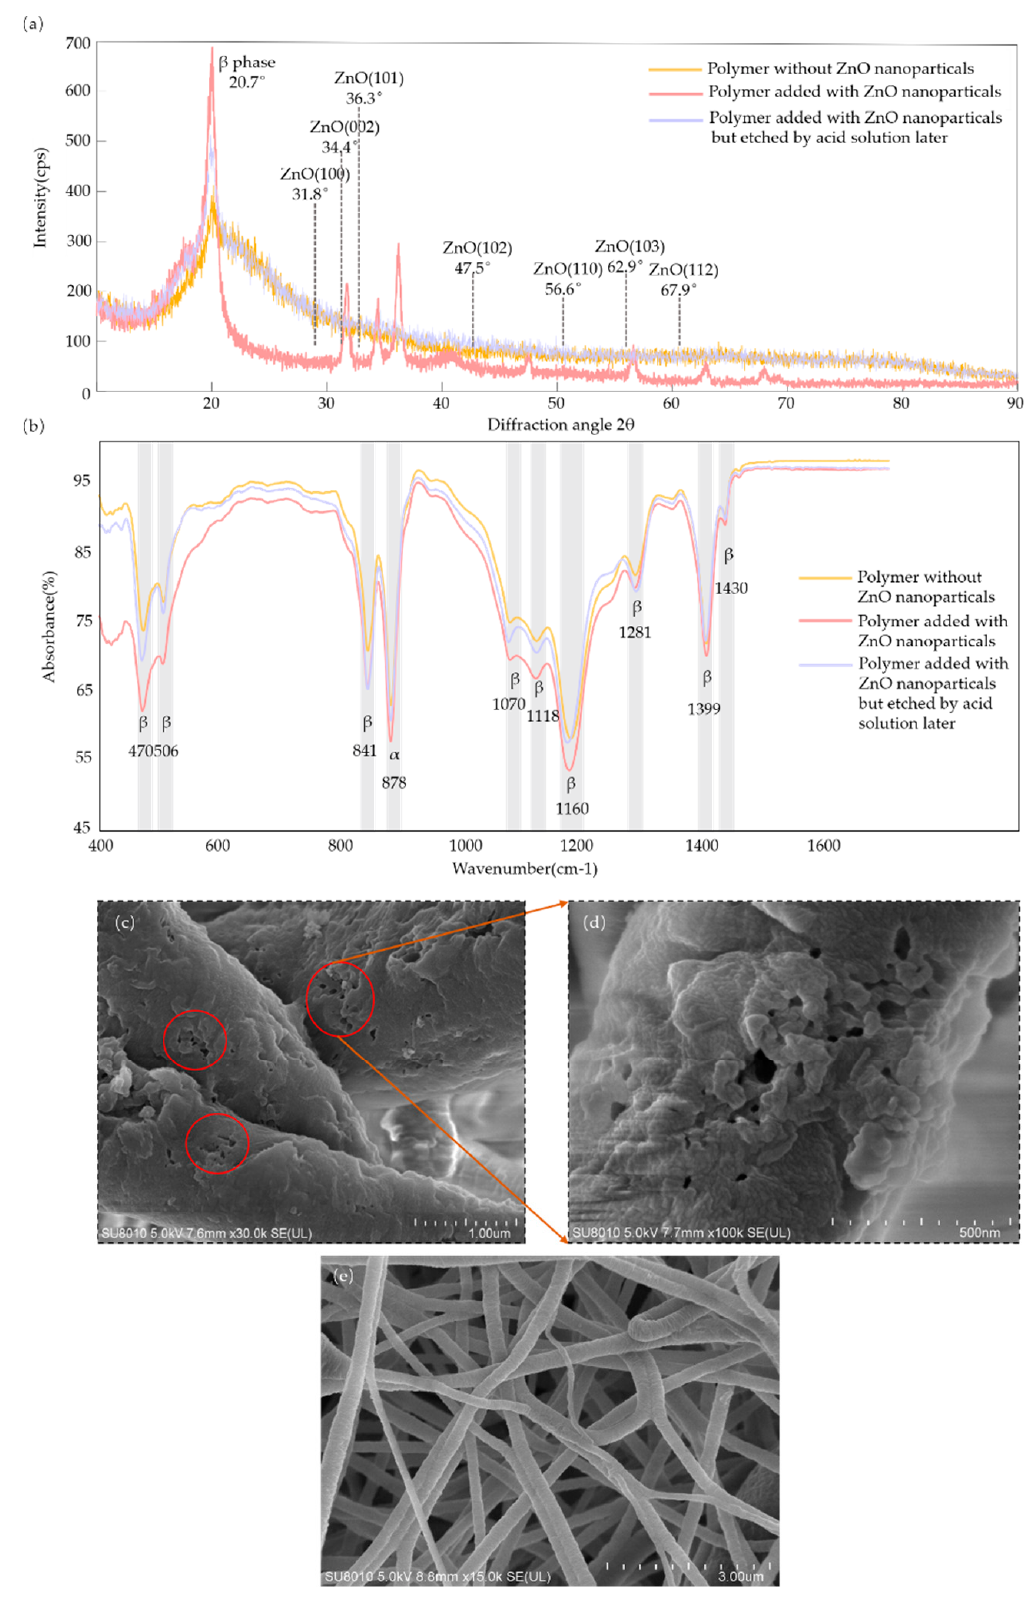
Figure 3. Schematic of analysis of the characteristics: ( a ) XRD spectra; ( b ) FTIR spectra of three kinds of P(VDF-TrFE) polymer film; ( c ) SEM image of nanoscale pores in the fibers (measuring scale in 1 micron). ( d ) Enlarged view of the nanoscale pores (measuring scale in 500 nm). ( e ) Overall morphology of the electrospinning fibers (measuring scale in 3 microns).